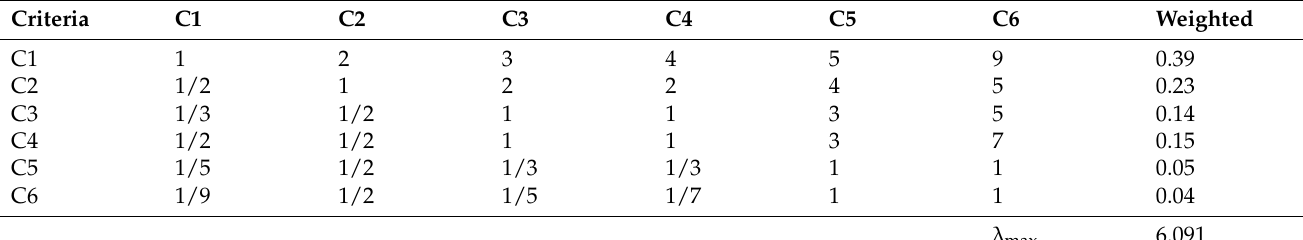
Table 6. The adopted decision criteria for solar plants evaluated in a